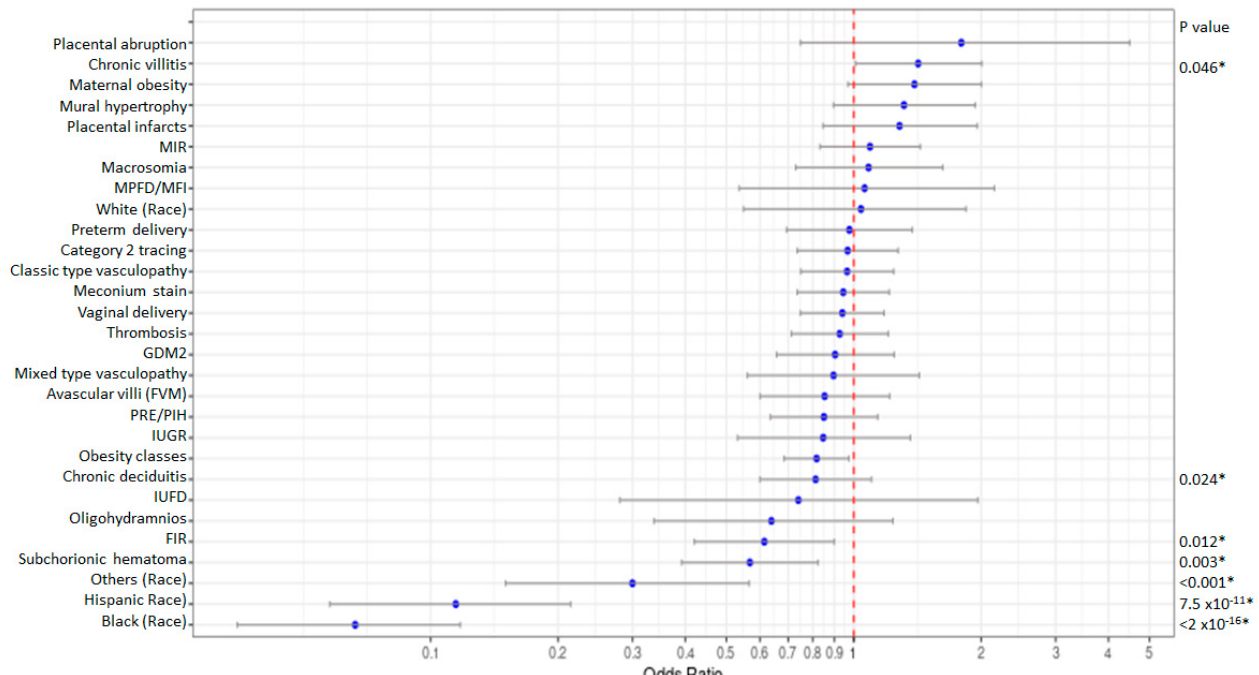
Figure 1. The odds ratio of the married and the single groups in association with various pregnancy complications and placental pathology by the logistic regression model. p < 0.05 is considered significant. The values expressed were mean with 95% confidence intervals (95% CI) .